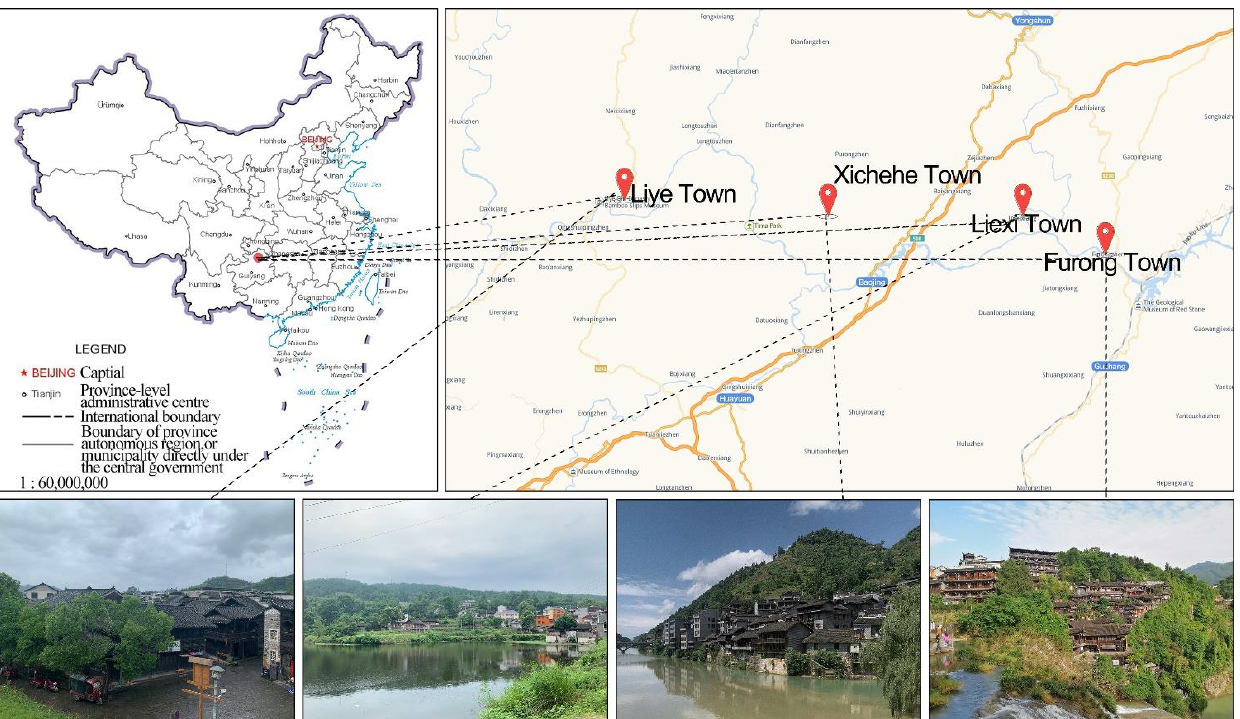
Figure 1. This is a figure. Schemes follow the same